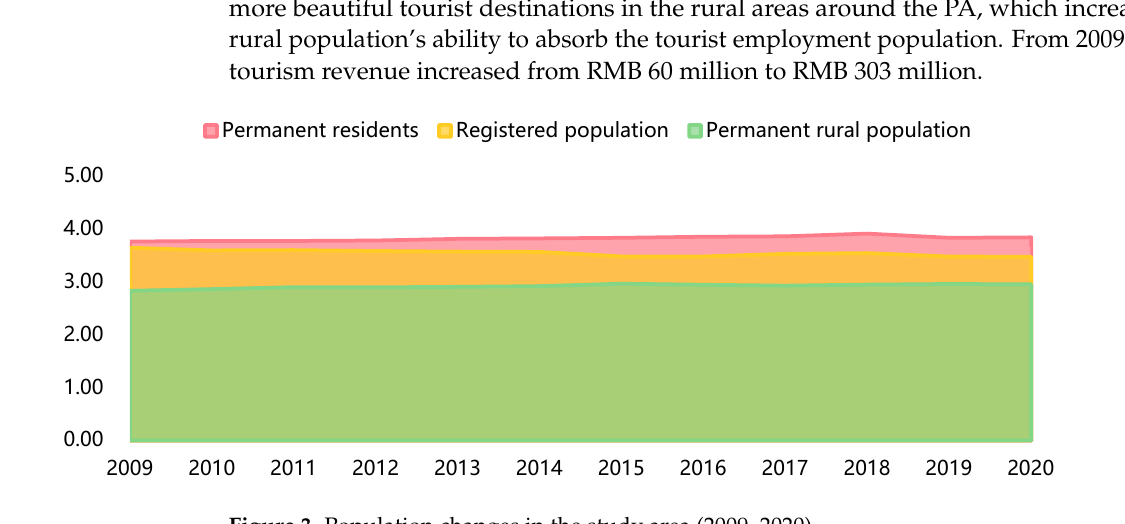
Table 1. Measurement results for population- and land-contraction values at three levels.